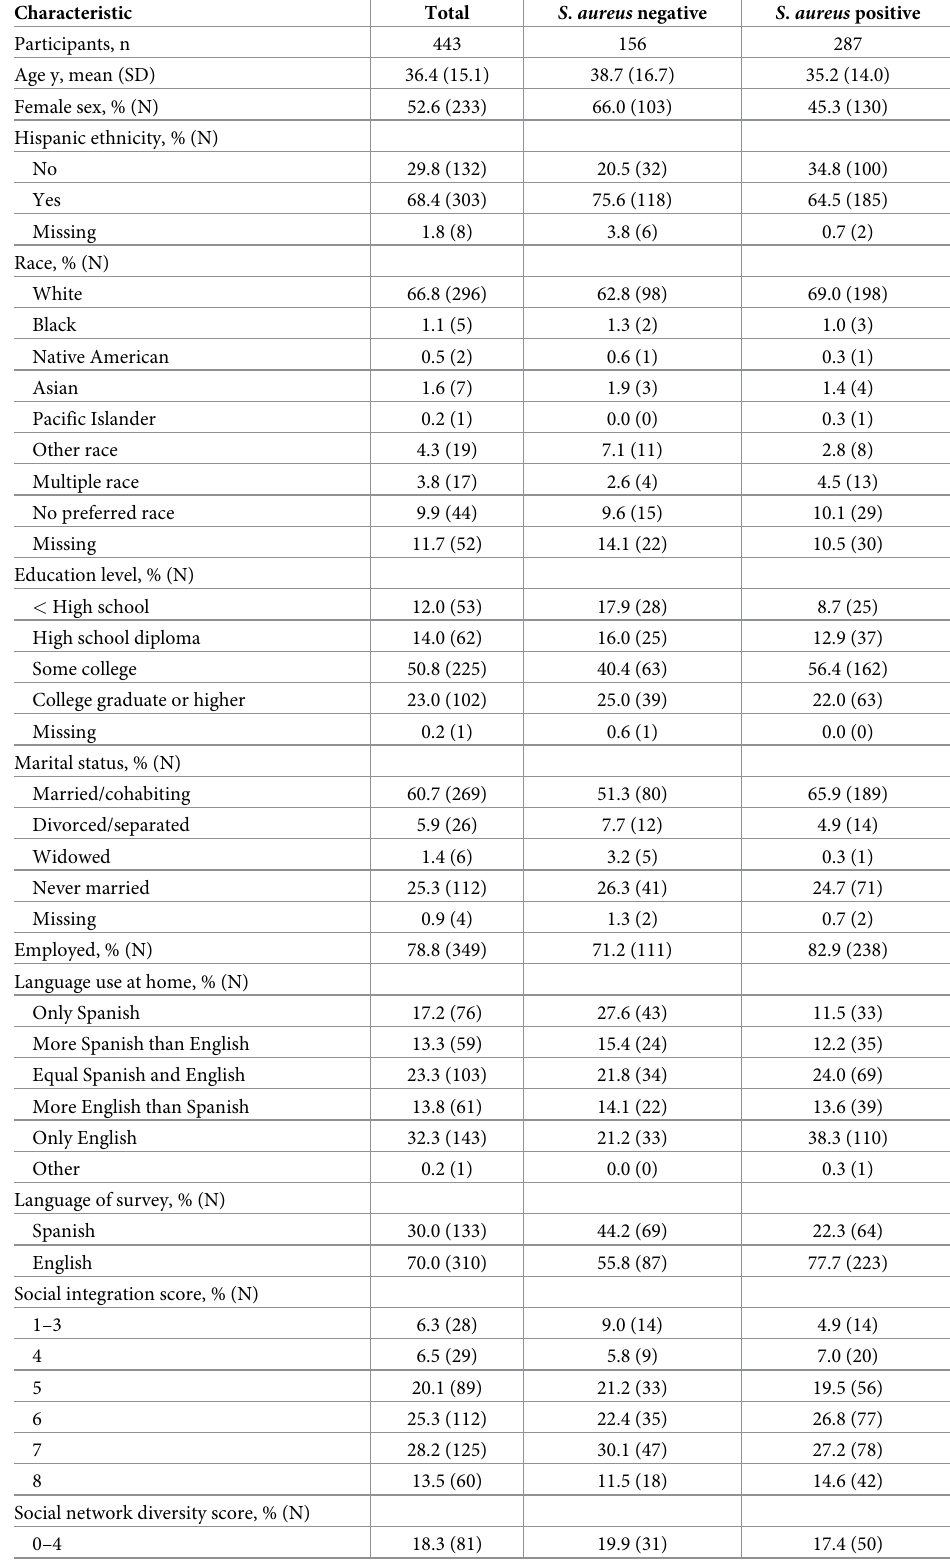
Table 1. Sample sociodemographic